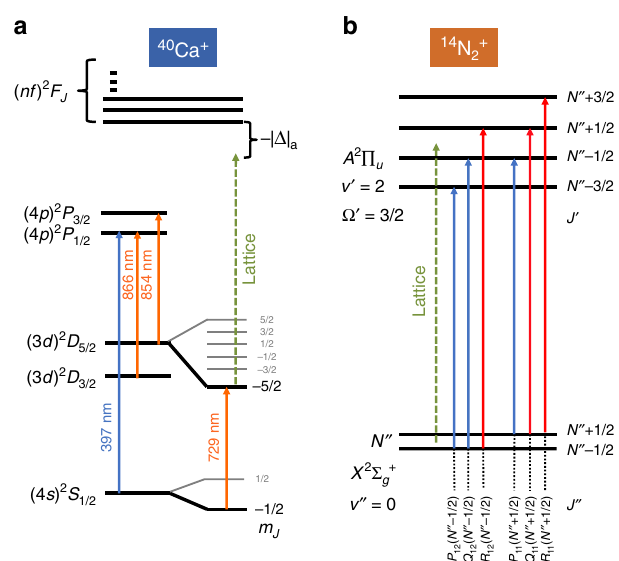
Fig. 2 Energy-level diagrams. a Reduced energy-level diagram (not to scale) of 40 Ca + relevant for Doppler and resolved-sideband cooling as well as motional state readout (solid arrows indicate transition frequencies). Motional excitation was initiated by a 1D lattice (dashed arrow indicates the laser frequency not to scale) which mainly interacted with the ( nf ) F J ( m = − 5/2) states (where n ≥ 4 and J = 7/2, 5/2) when Ca + was shelved in the (3 d ) 2 D 5/2 ( m = − 5/2) level. The transition wavelength to the F states is smaller than 184 nm such that the lattice at 789 nm is far red detuned. b Simpli fi ed energy-level diagram (not to scale) of the A 2 Π u ð v 0 ¼ 2 Þ ð v 00 ¼ 0 Þ band of 14 N þ X 2 Σ þ . Solid arrows indicate the possible transitions g 2 from a single rotational level (split into two spin – rotation components) of the ground vibronic state. Red (blue) arrows indicates red (blue) detuning of the lattice frequency (dashed green arrow) with respect to the relevant